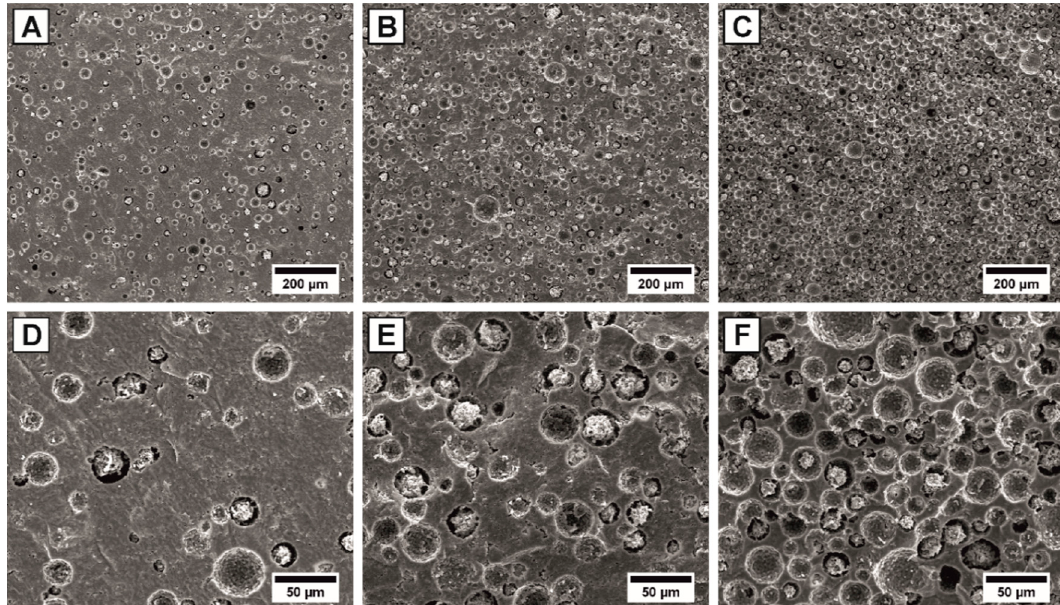
Figure 3. SEM-micrographs of fracture surfaces showing the microstructure of the porous HAp samples containing 10 ( A,D ), 20 ( B,E ) and 40 ( C,F ) Vol% of 20 µm spherical pore formers. The lower 250× magnification images of ( A – C ) display the homogeneous distribution of the pores, while the higher 1000× magnification images of ( D – F ) show the change of connectivity from isolated to interconnected pores.